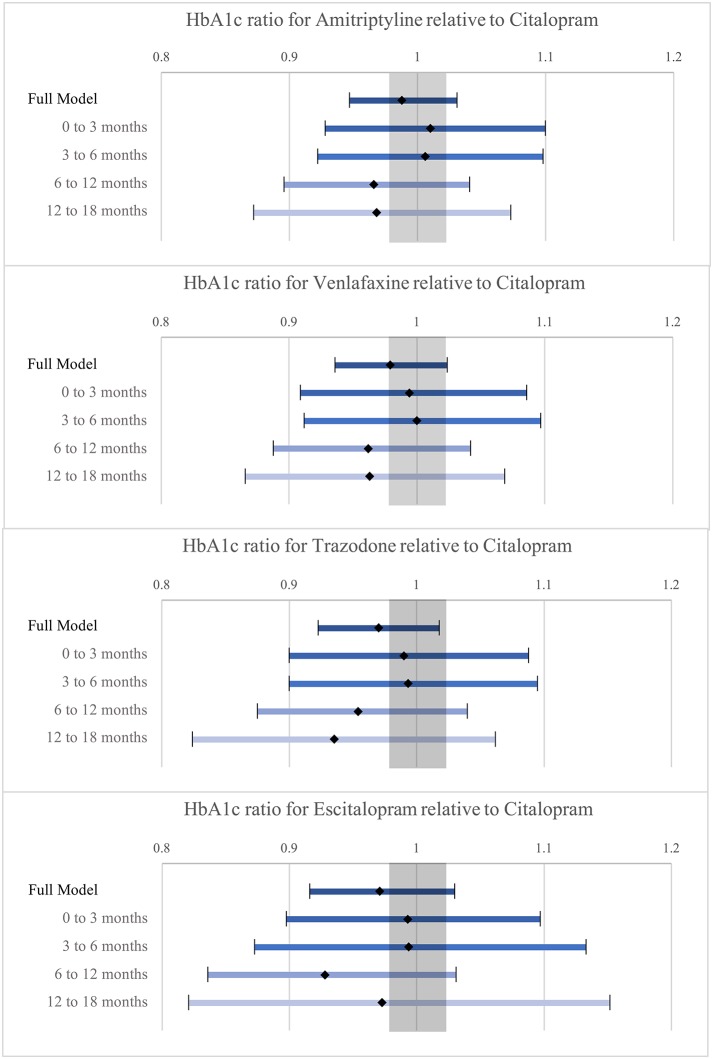
Illustration of the Mean HbA1c ratio estimates of Amitriptyline, Venalafaxine, Trazodone and Escitalopram relative to Citalopram with 95% confidence intervals (shaded area corresponds to minimum detectable effect size).